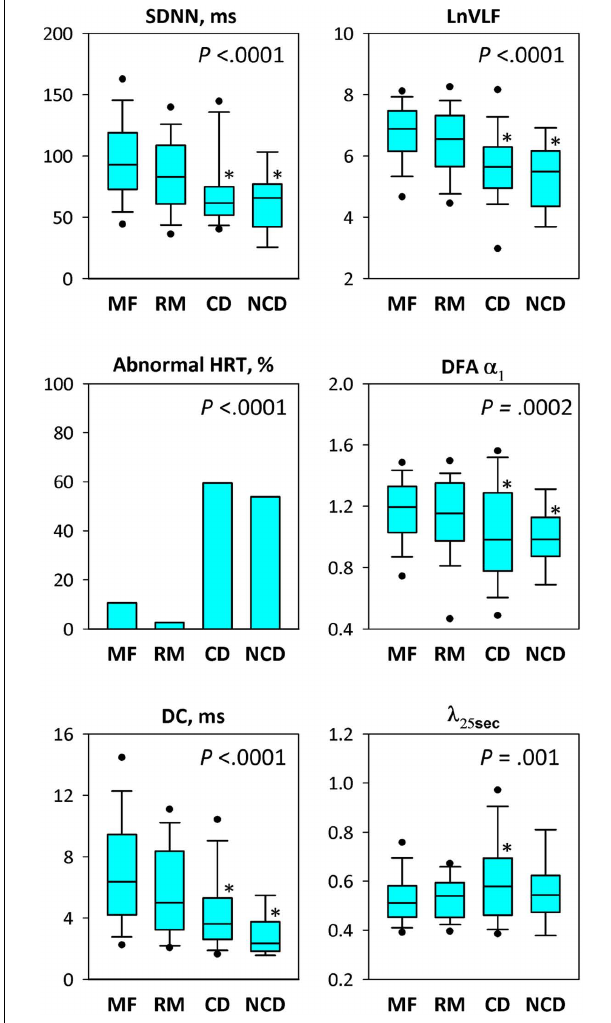
FIGURE 3 |Trend graphs of 24-h N–N interval in three representative patients, recurrentAMI-free survivor (A), cardiac death (B) and non-cardiac death (C), and their standardized PDF of intermittent heart rate increments (D). Insets of panels (A–C) show values of HRV indices obtained from each N–N interval time series. In panel (D) , the Gaussian distribution ( λ 25s = 0), an inverted parabola in this semi-log plot without “tapered” centers and “fat” tails, is shown as a dashed line. Abbreviations for HRV indices are defined in the